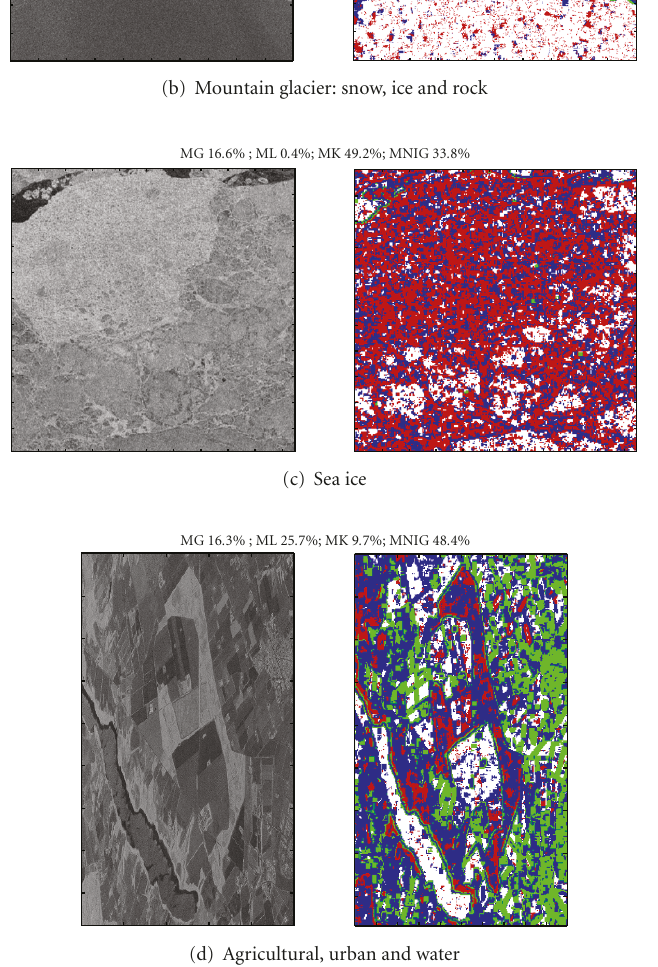
Figure 5: Intensity and “best fit” coloured maps for the four areas: Gaussian in white, Laplacian in green, K-distribution in red, and normal inverse Gaussian in